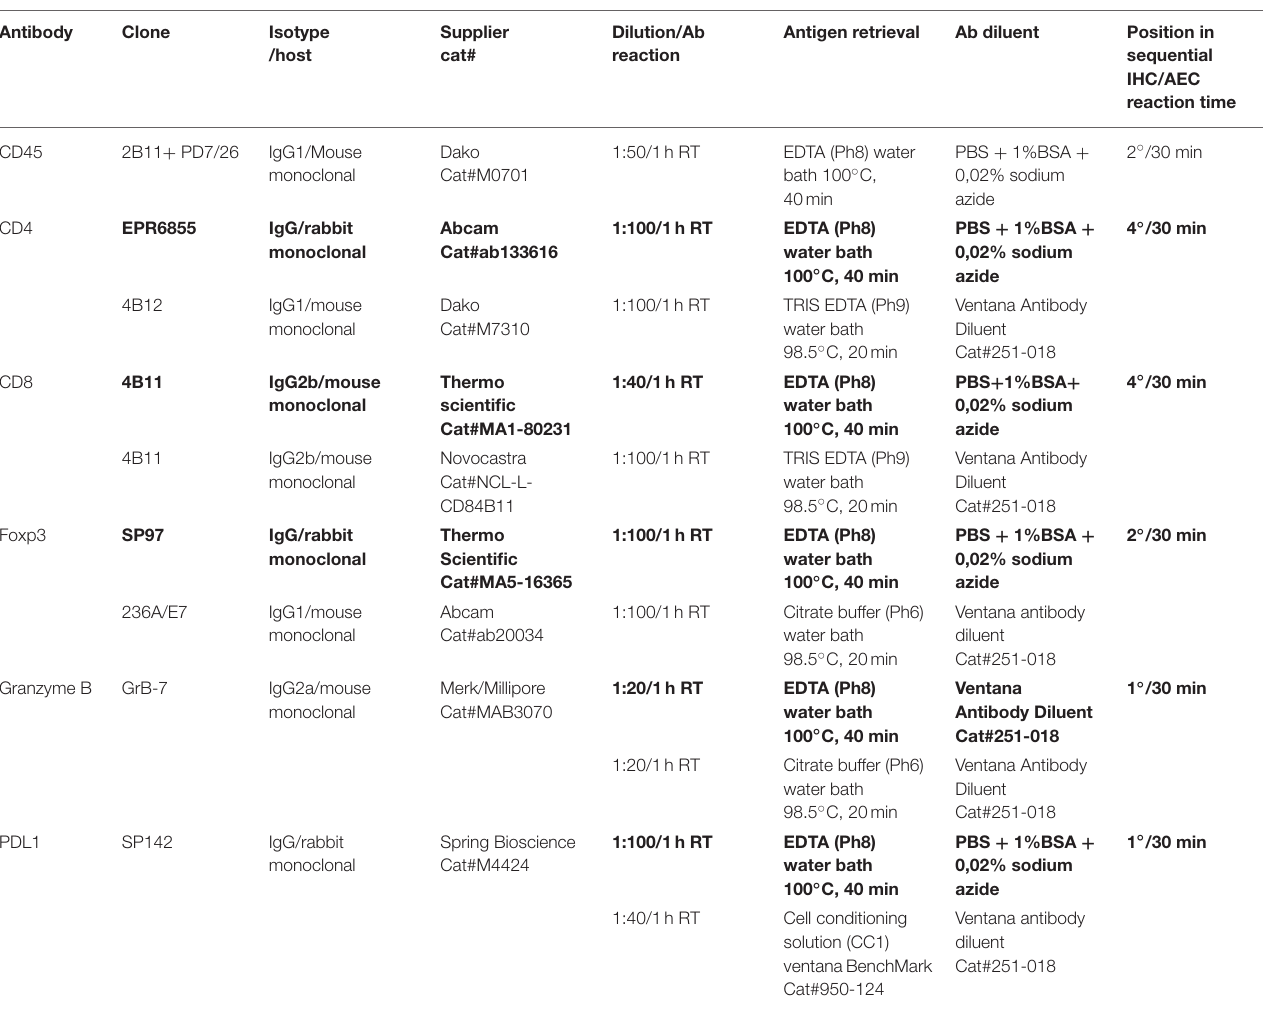
TABLE 2 | Details of IHC antibodies.